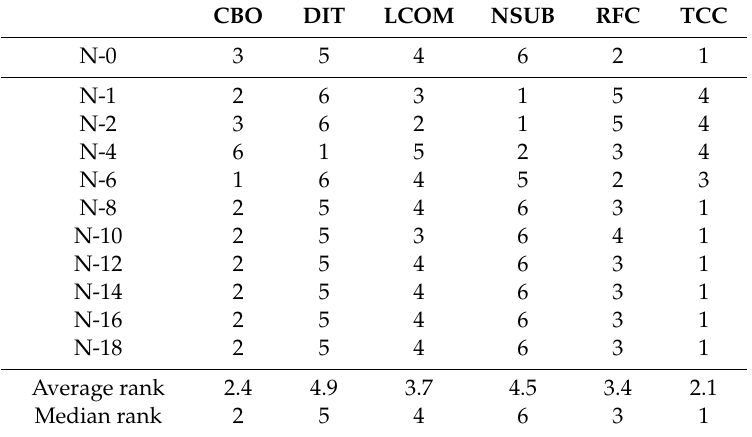
Table 9. Ranks of software metrics in the software metric importance calculations–smaller ranks indicate more important